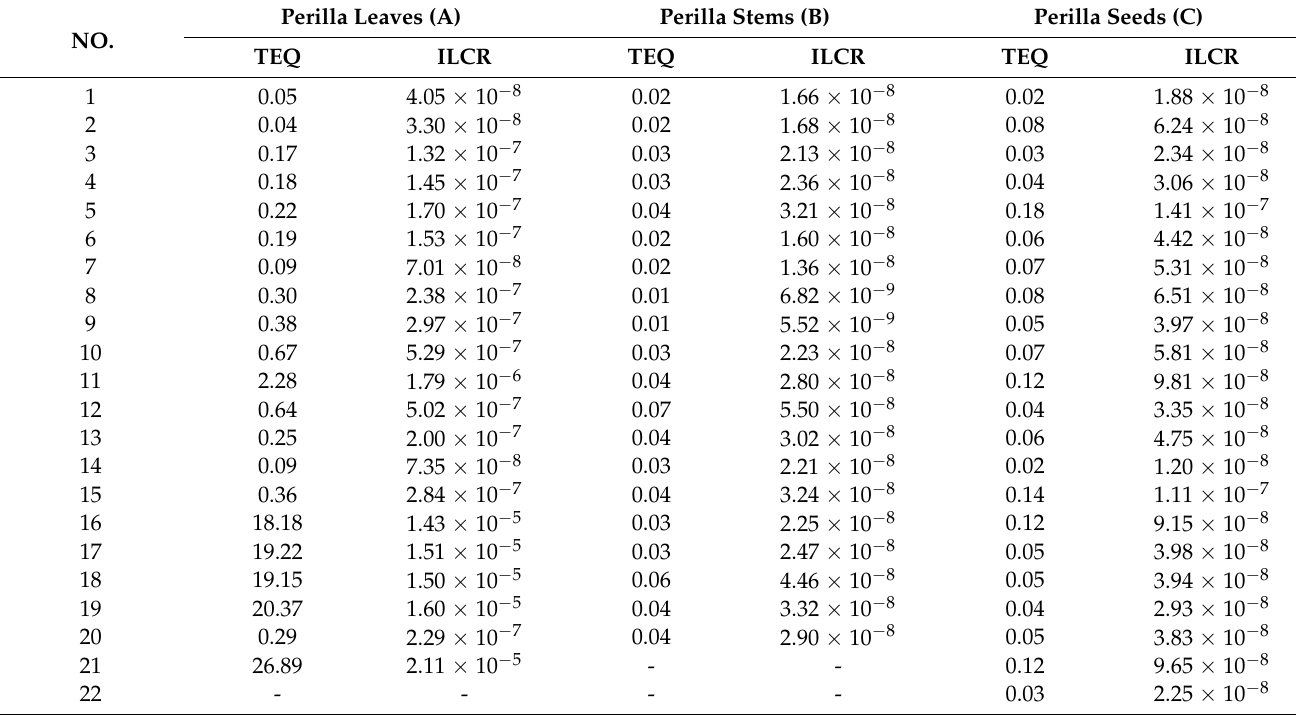
Table 2. The results of TEQ (ng/g) and ILCR for all